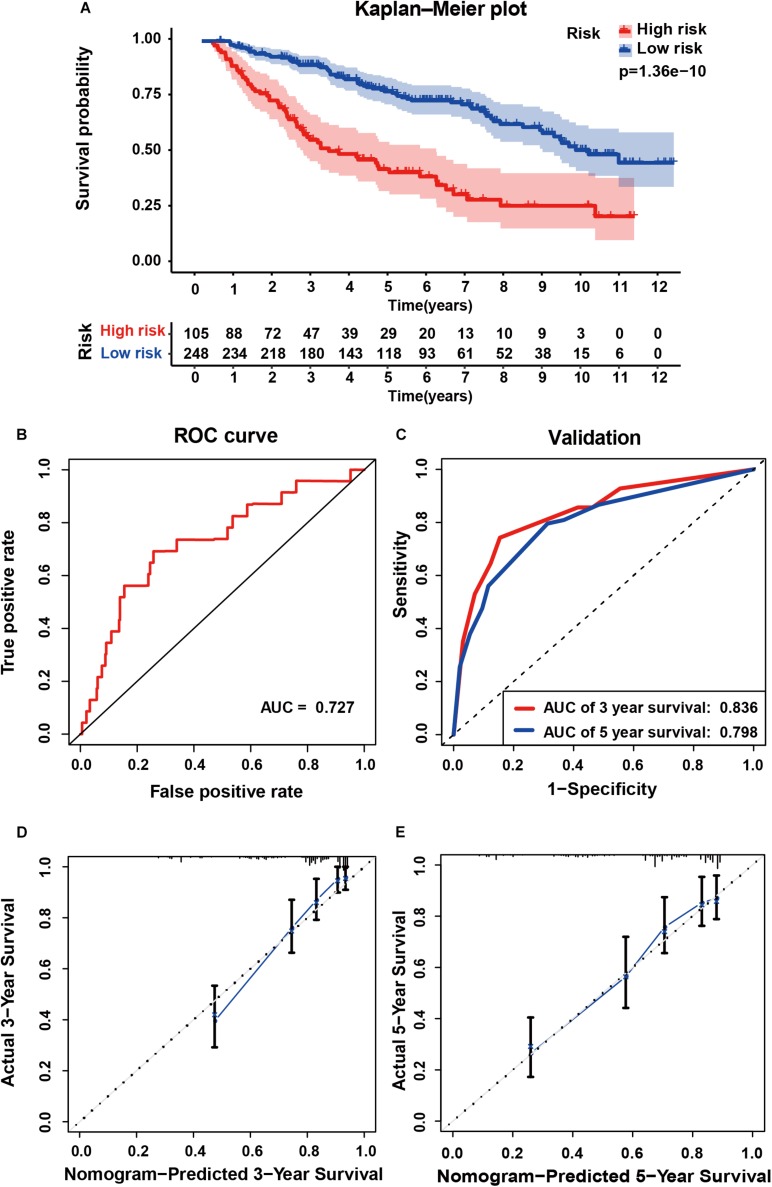
External validation of the six gene signature in primary LGG inform the CGGA dataset. (A) Kaplan-Meier survival curves of the six gene signature of patients with primary LGG in the CGGA cohort. (B) ROC curve for assessing diagnostic competence of the risk score in the CGGA cohort. (C) ROC curves for 3-, and 5-year OS predictions for the six gene signature in the external validation cohort. Calibration curves for predicting probabilities of 3-year (D), and 5-year (E) OS of patients in external validation.